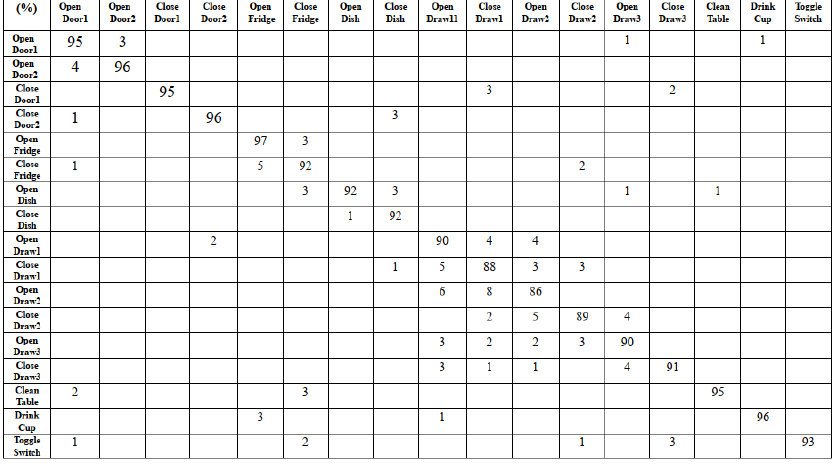
Figure 10. The confusion matrix result of our DNN method on different human activities.